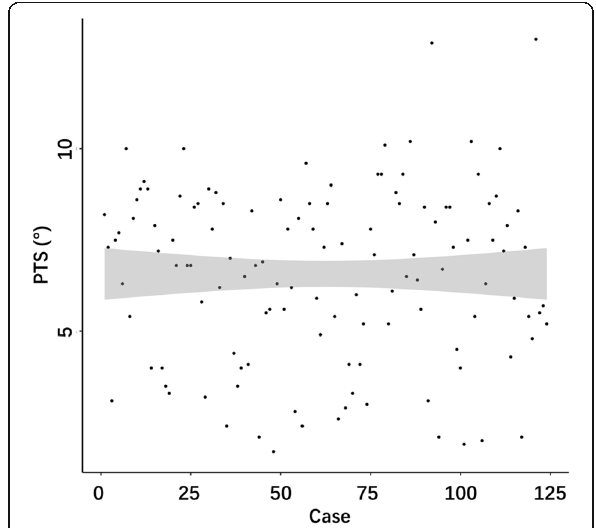
Fig. 3 The scatter plot graphs illustrating the PTS distribution trend of 113 patients (involving 124 knees)